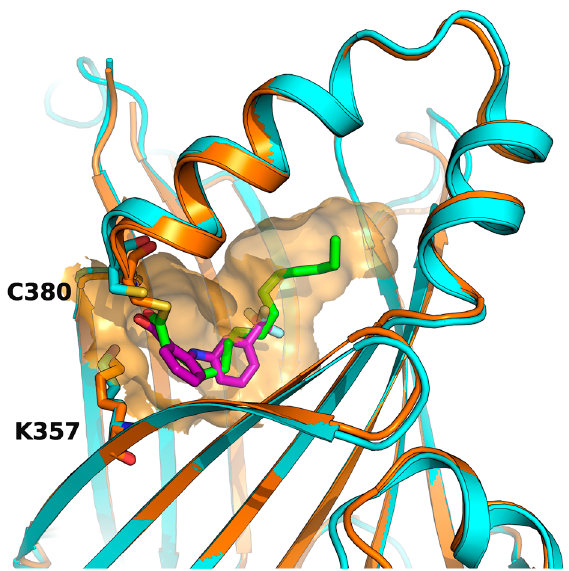
Figure 5. Flufenamic acid (in purple as part of the PDB structure 5DQ8 , in cyan) and palmitate (in green as part of the PDB structure 5EMV , in orange) share the same binding pocket as shown by superposition of co-crystallized hTEAD2 structures. The surface of the amino acid residues lining the binding pocket of hTEAD2 is represented in orange.